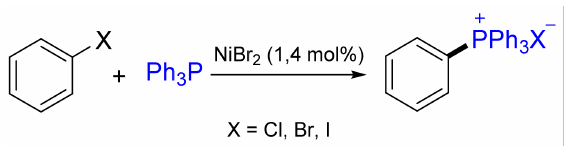
Figure 17. Nickel-catalyzed quaternization of